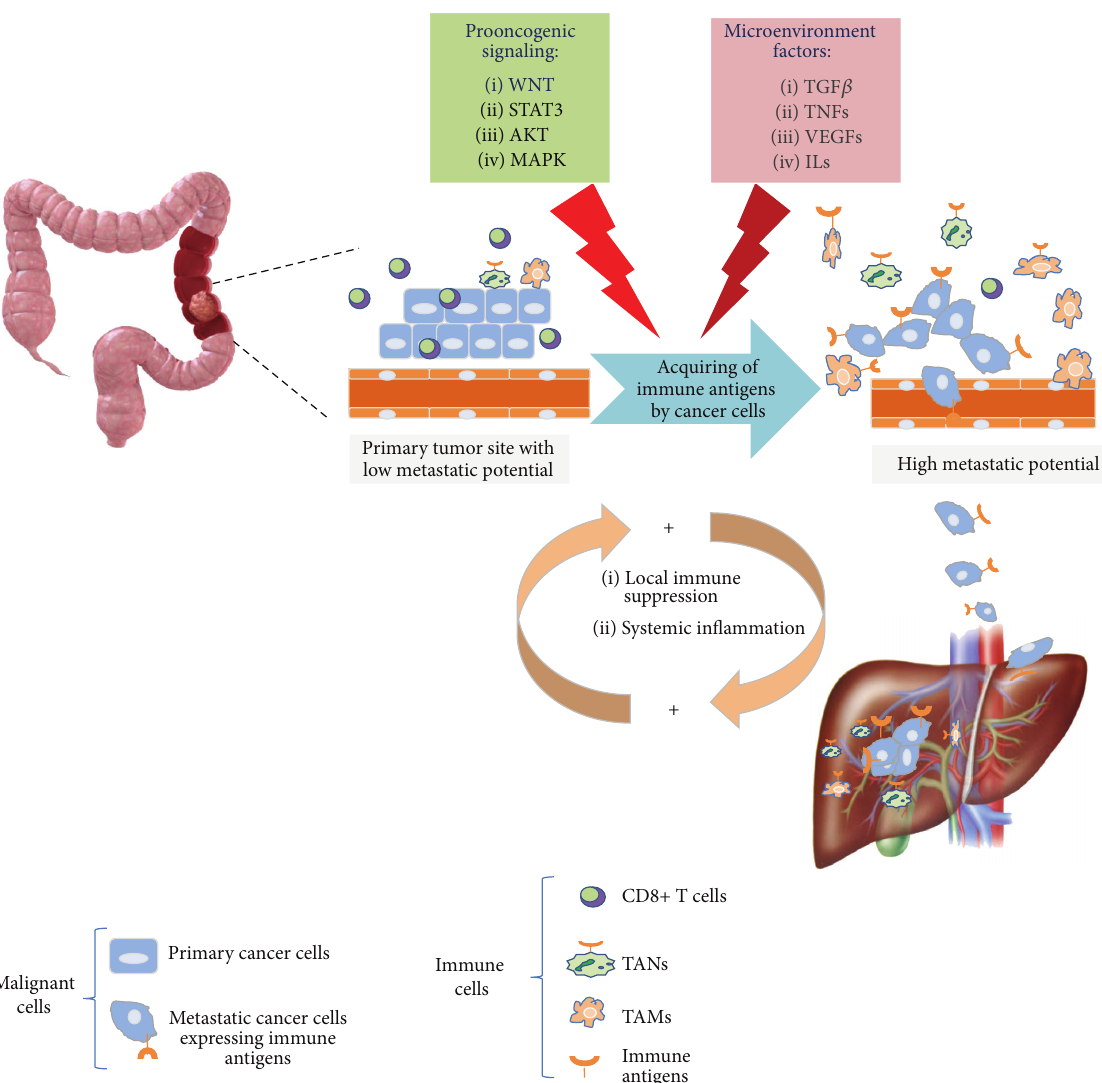
Figure 2: Immune antigens expression by cancer cells contributes to the metastatic cascade. Most malignant solid tumors metastasize from the primary organ to another, such as the liver. At the primary site, potentially immunogenic tumor cells are being exposed to the immune system. High density of TILs and tumoricidal immune response mediated by killer cells and CD8+ T cells restrict the tumor outgrowth. Genetic damage and deregulated signaling pathways accompanied by the production of various cytokines and chemokines in the tumor microenvironment can induce expression of immune antigens on the cancer cell surface. By these changes, the tumors promote recruitment and expansion of prometastatic myeloid cells, TAMs, or TANs, respectively. As such, immune-like phenotype enables cancer cells to increase metastatic potential and avoid immune surveillance at different levels during the metastatic cascade. The circulating tumor cells expressing an immune-like phenotype, that is, CD47, are then arrested in microvessels in the metastatic site where they need to survive. At the metastatic site, the arrested tumor cells escape from the resident myeloid cells and survive at the metastatic niche and proliferate to form the deadly metastatic tumor. Recent studies suggest that MAMs sustain the survival and persistent growth of emigrated cancer cells. TANs also promote the entrapment of circulating cancer cells by producing neutrophil extracellular traps (NETs). TAMs: tumor associated macrophages; MAMs: metastasis-associated macrophages; TANs: tumor associated